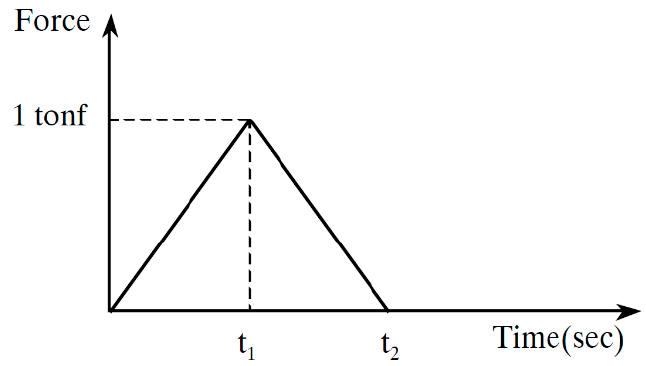
Figure 9. Dynamic load of the vehicle on the 3D model concept.